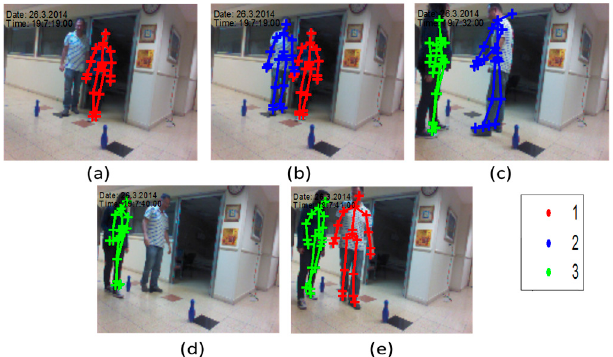
Figure 5. The five different subject indexes assignments, which represent different KIs, for the two